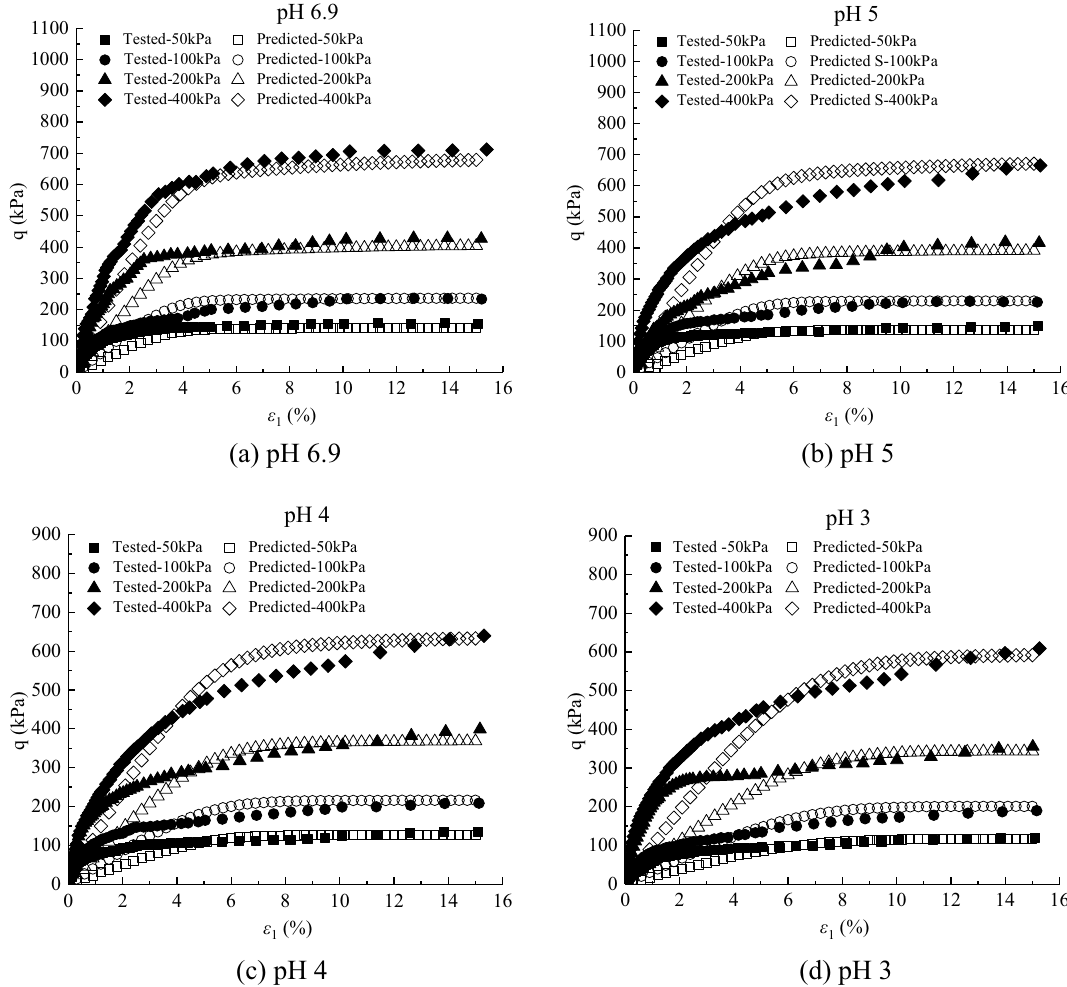
Figure 9. Deviatoric stress–axial strain for tests and